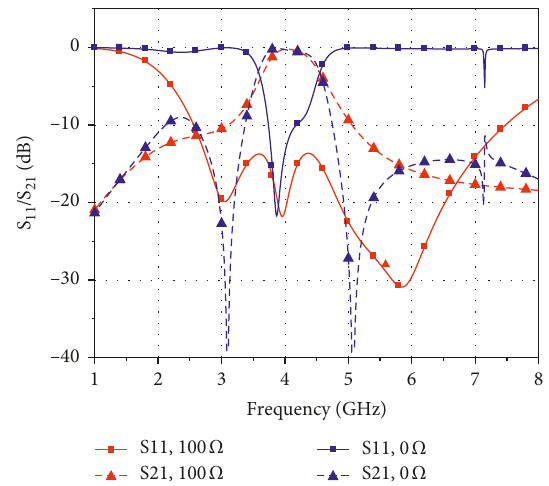
� 1 . 72 mm, l � 20mm, 0 0